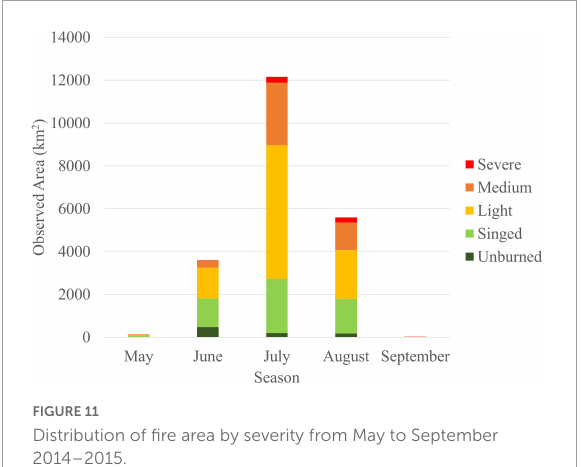
FIGURE11 Distribution of fire area by severity from May to September